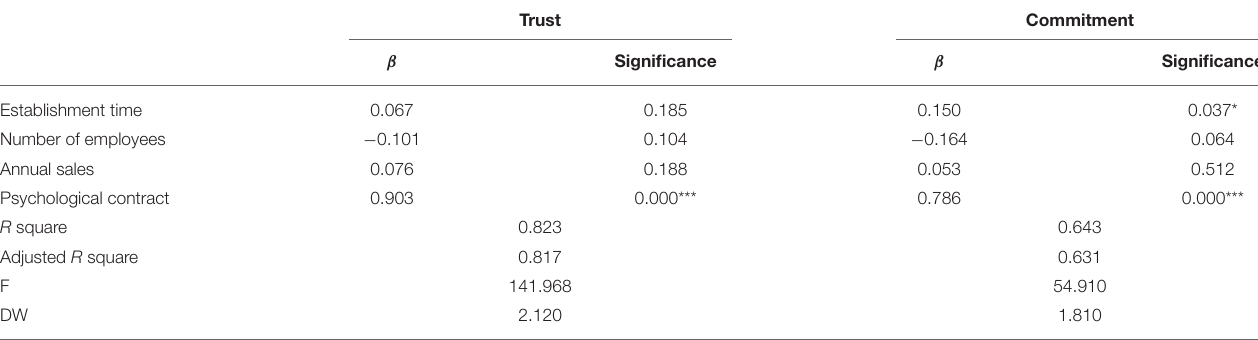
TABLE 2 | Regression analysis results of psychological contract and relationship quality.